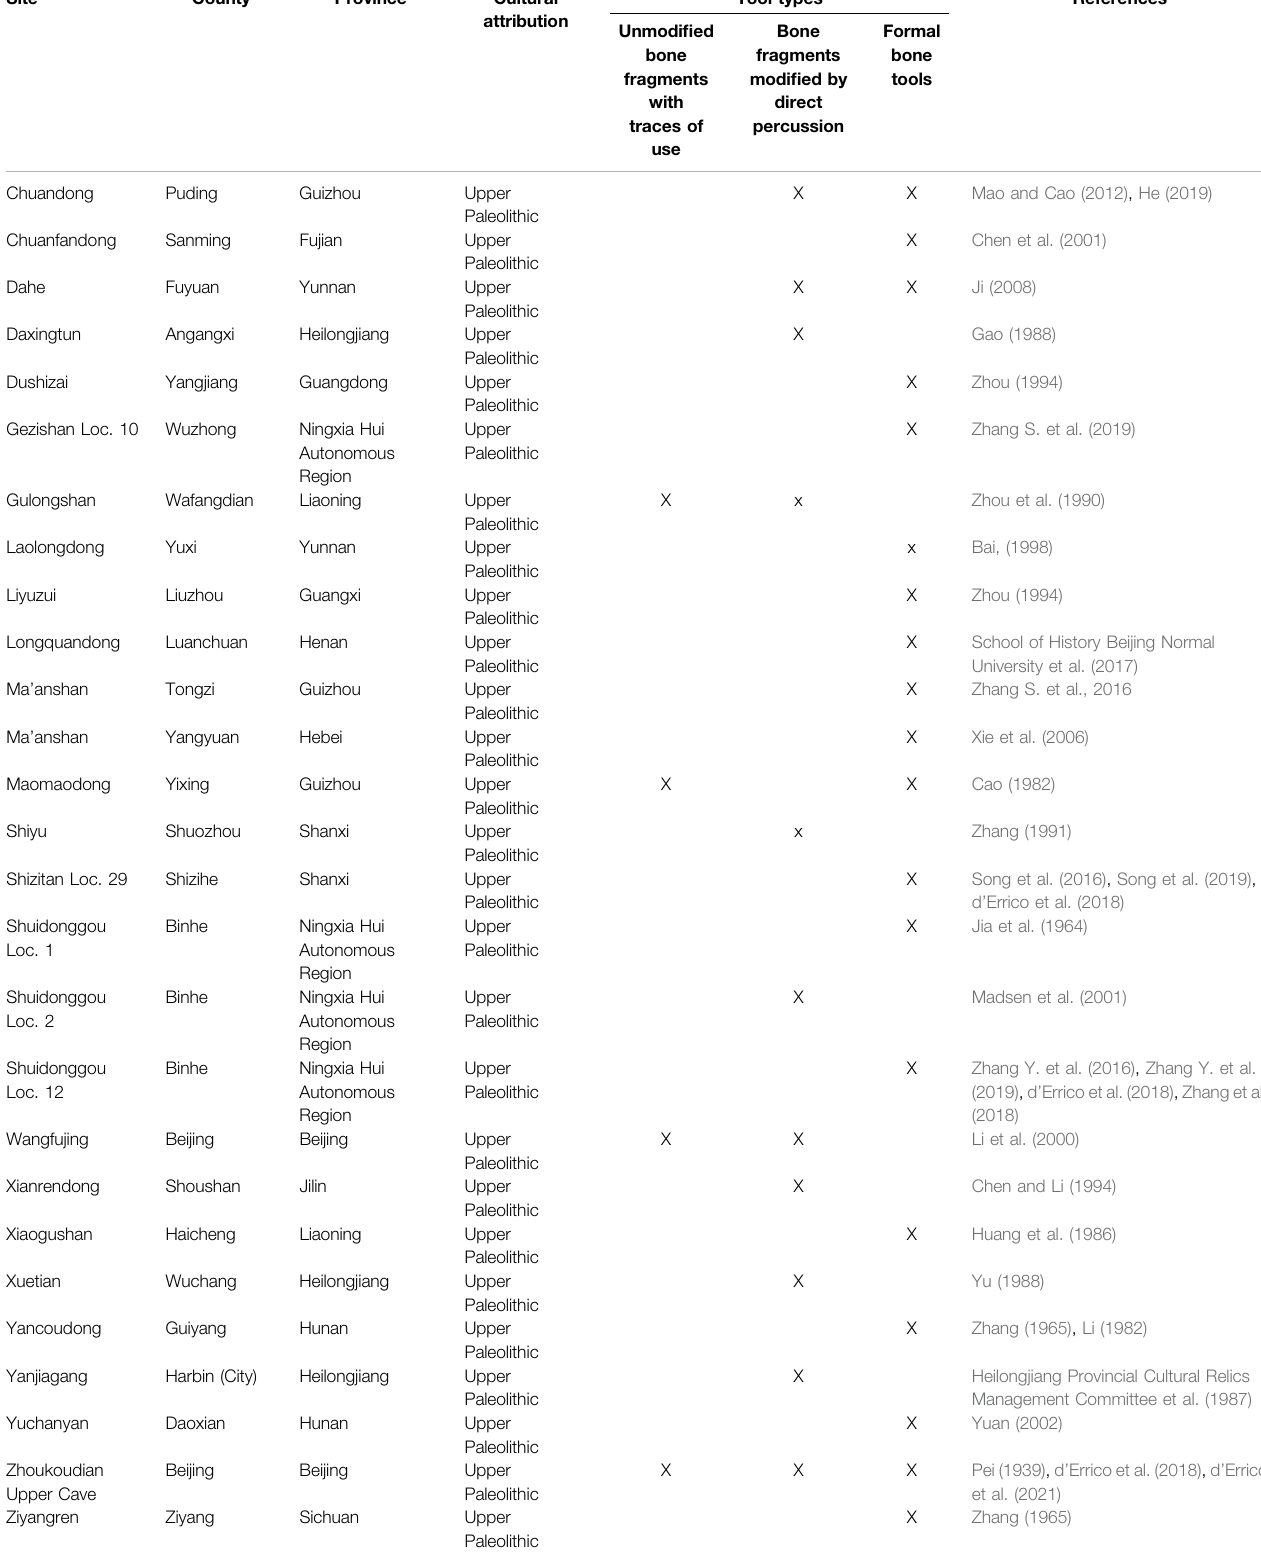
TABLE 1 | ( Continued ) Summary of occurrence of Pleistocene osseous technology in